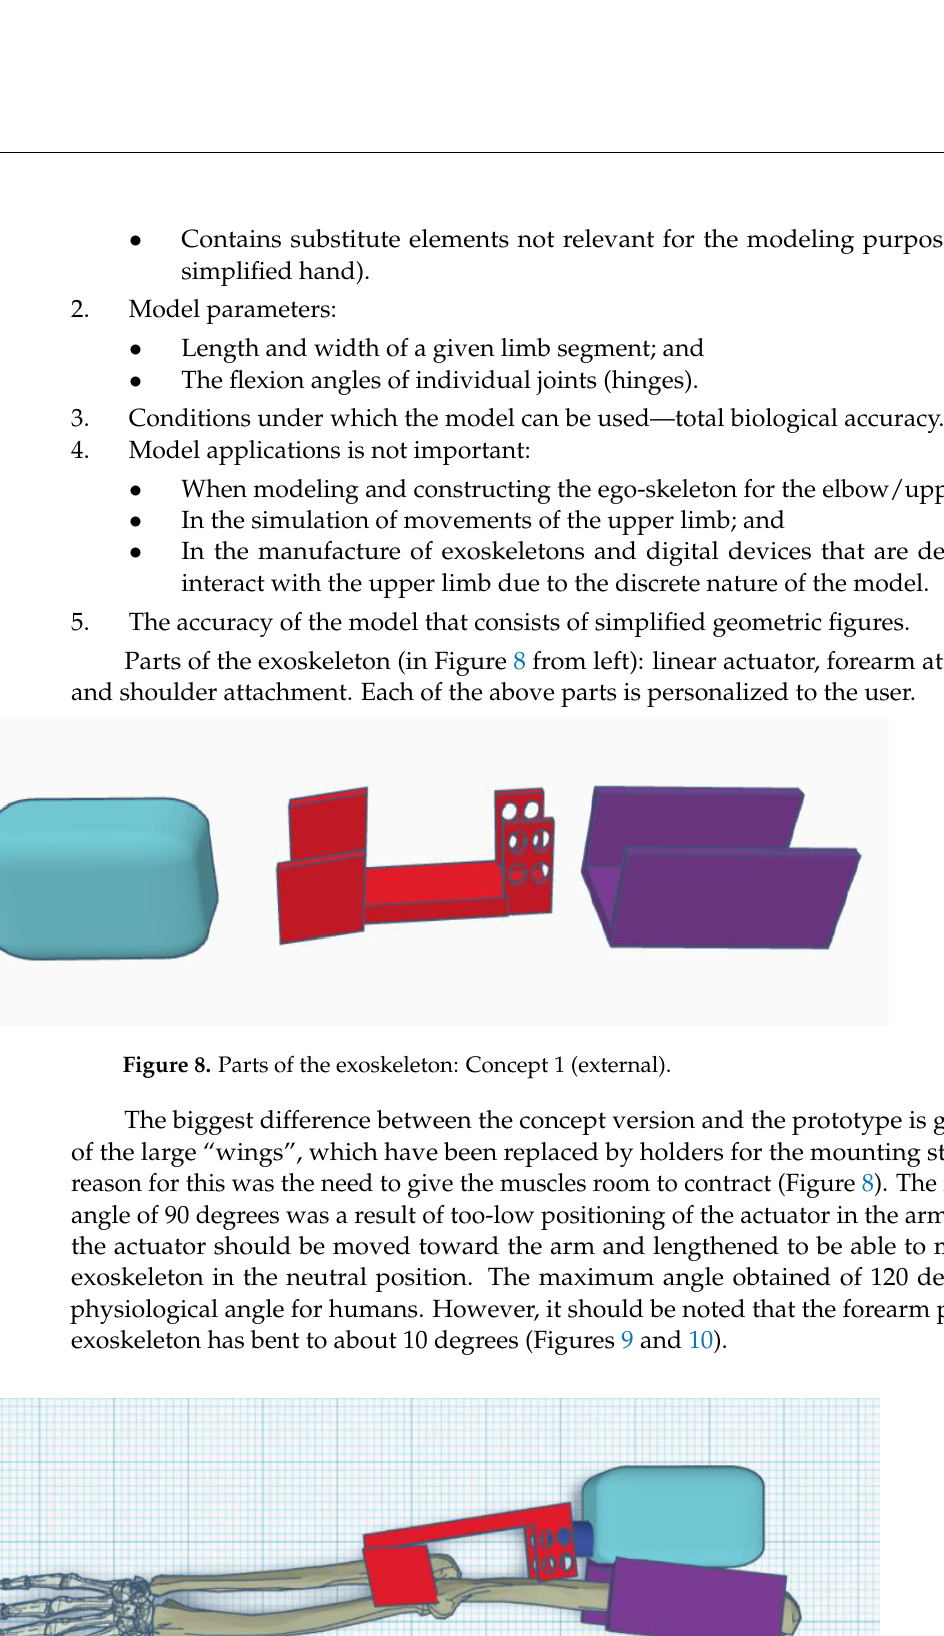
Figure 10. Flexed exoskeleton with arm (120  ). 3.2. Concept 2 (Internal) Parts of the exoskeleton include (in Figure 11 from left): linear motor, forearm part, and shoulder part. Figure 11. Parts of the exoskeleton: Concept 2 (internal).